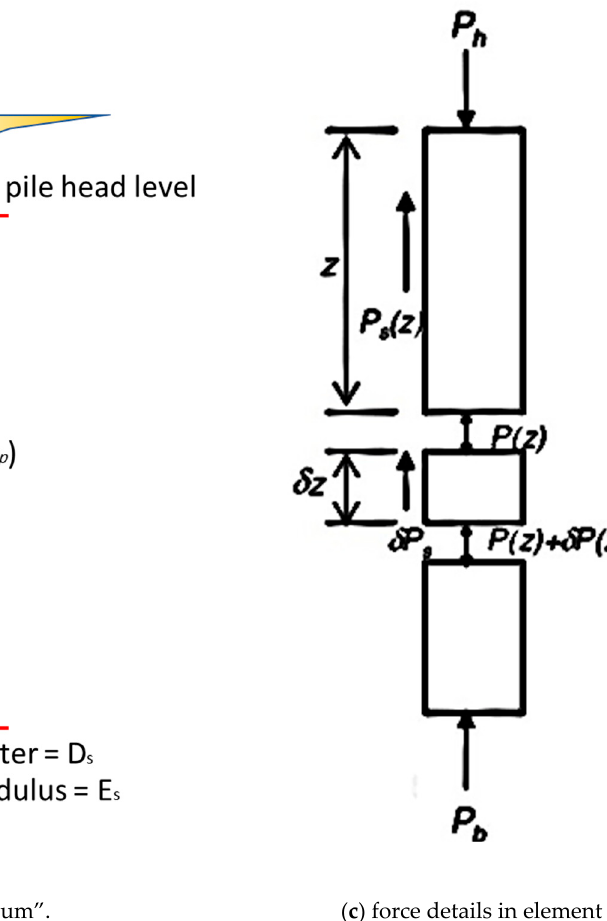
Figure 1. Displacement and force of loaded bored pile–soil; ( a ) schematic representation, ( b ) forces on a pile element in “equilibrium., ( c ) force details in element with length of δ z .